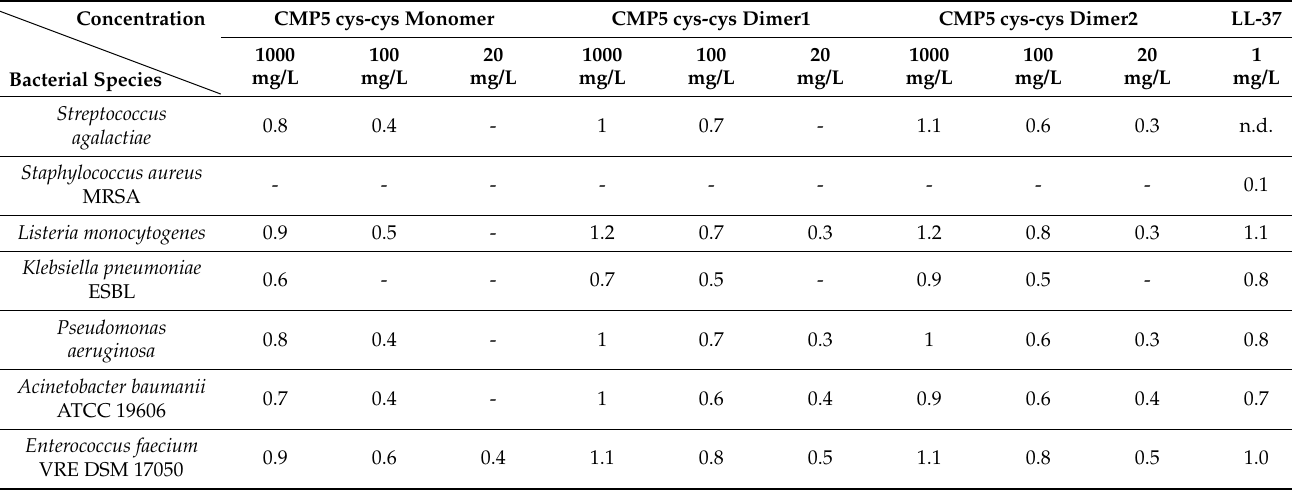
Table 1. Agar diffusion test of Gram-positive and Gram-negative bacterial species against the antimicrobial peptides CMP5 cys-cys monomer and dimer 1 and dimer